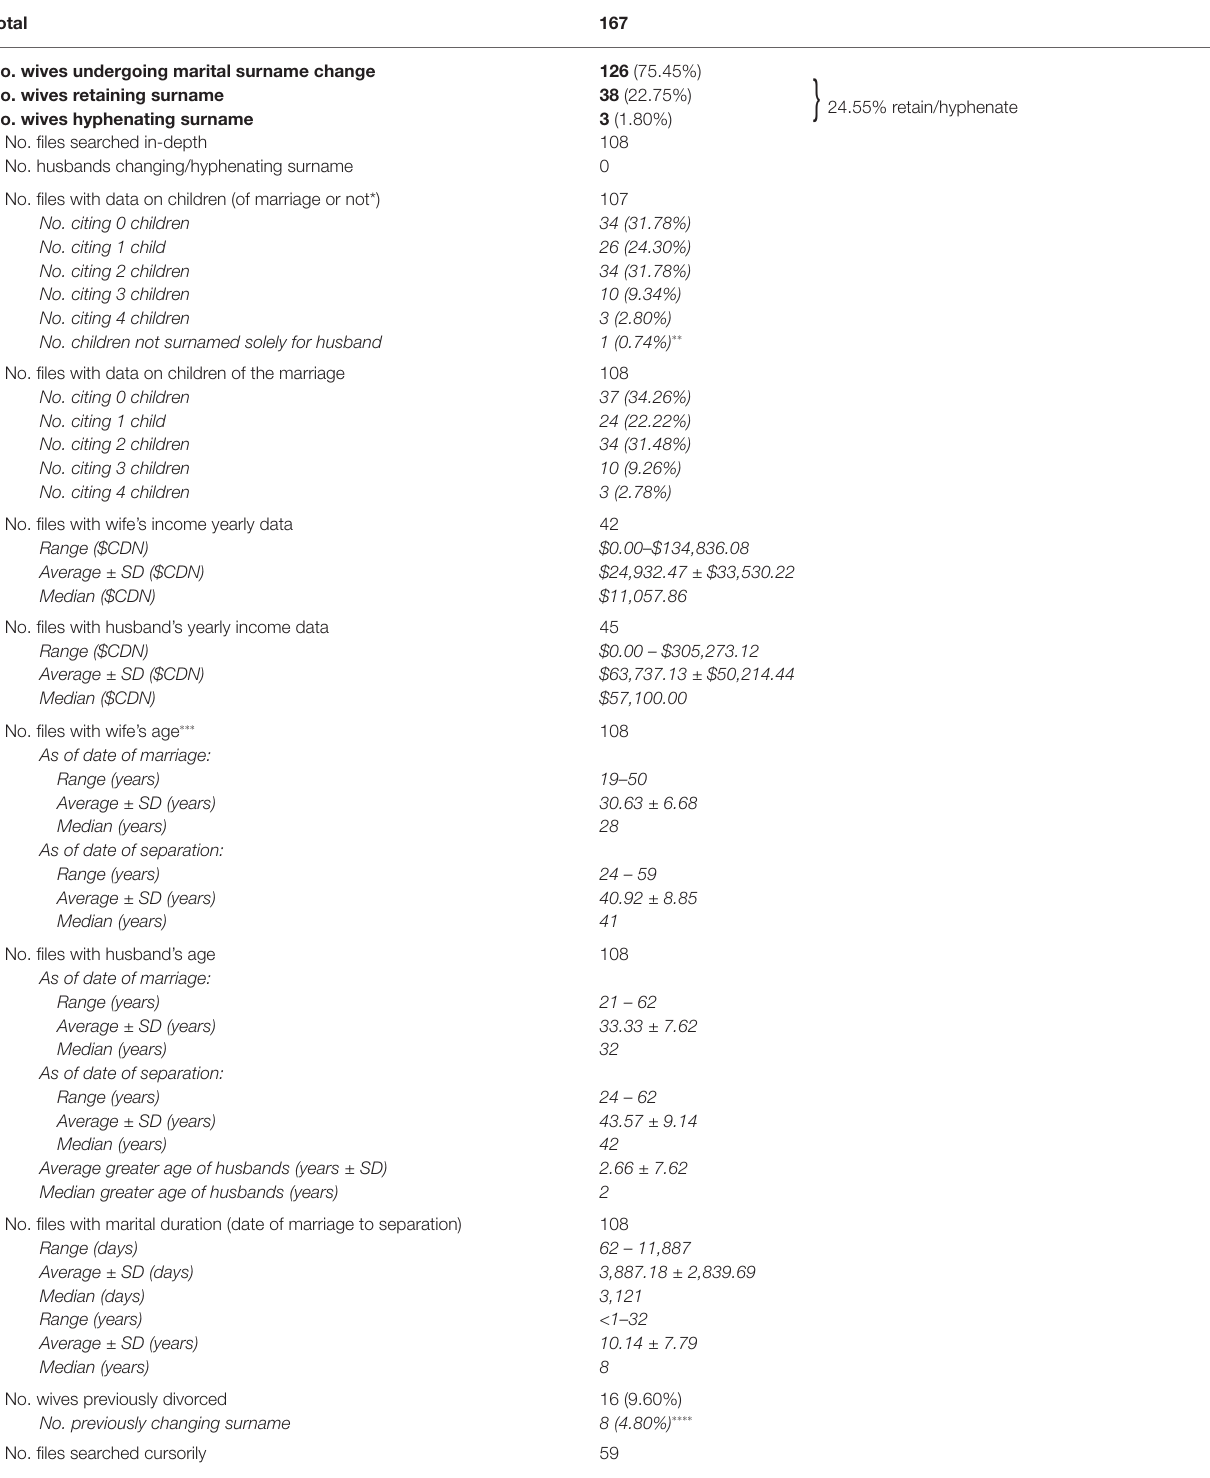
TABLE 2 | Sample descriptive statistics: Out of total number of couples’ divorce files searched ( N = 167), number providing data of each type. Total